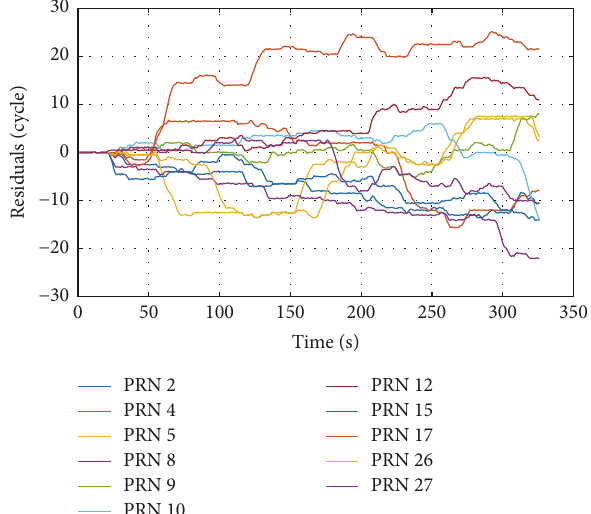
Figure 11: Single difference of carrier phase between 47 dB-Hz and 15dB-Hz data sets with PLL.